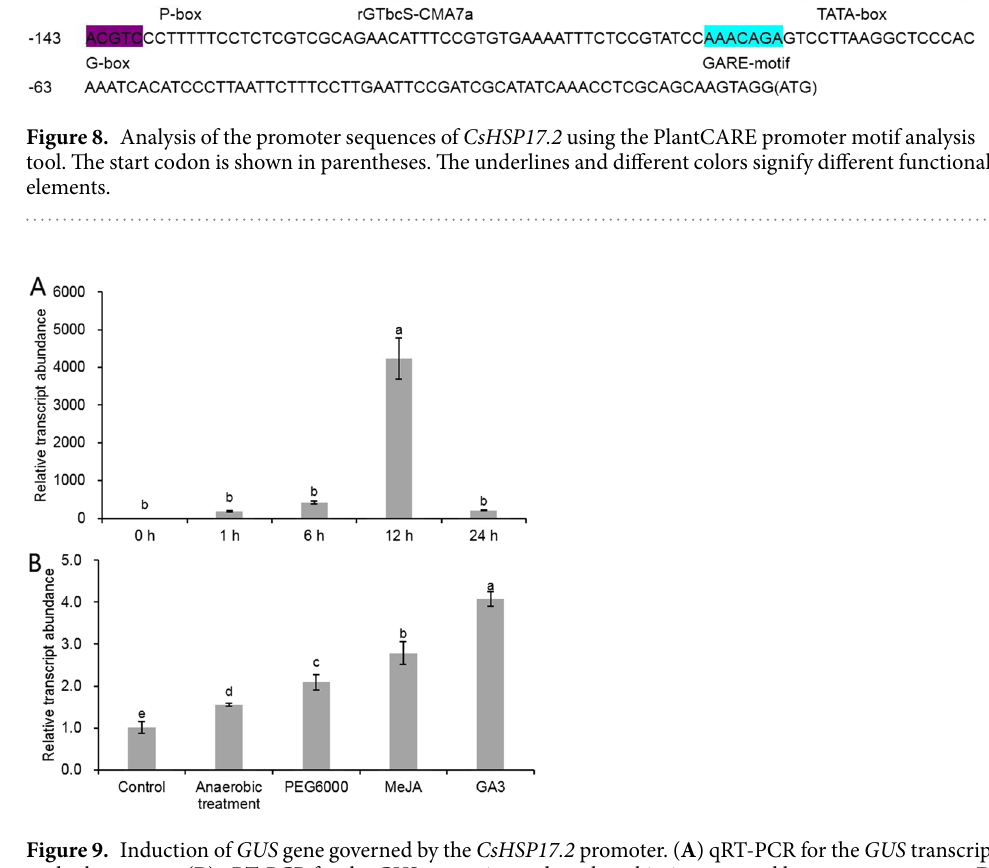
Figure 9. Induction of GUS gene governed by the CsHSP17.2 promoter. ( A ) qRT-PCR for the GUS transcript under heat stress. ( B ) qRT-PCR for the GUS transcript under other abiotic stress and hormone treatments. Data represent the means ± standard deviations of four replicates, and the significant differences are indicated by different letters ( P <